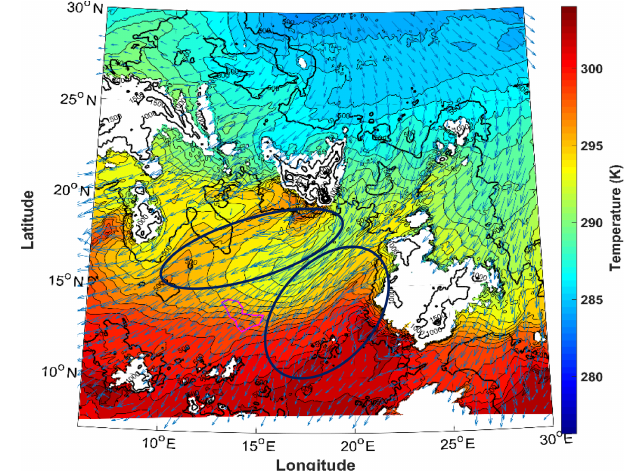
Figure 10. Temperature and wind speed and direction at 925hPa at 18:00UTC on 8 December 2011 (6km resolution WRF product). Blue arrow lines indicate the wind flow. Blue circled areas indi- cate one wind component was flowing west-southwest close to the mountains as it turns to the right and the other wind component was turning to the left away from the mountains farther north and east as it goes